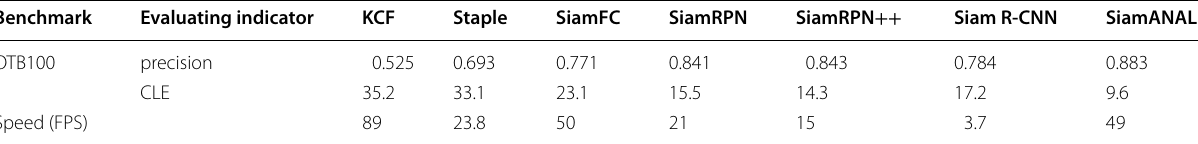
Table 3 Comparison of precision and CLE on OTB100